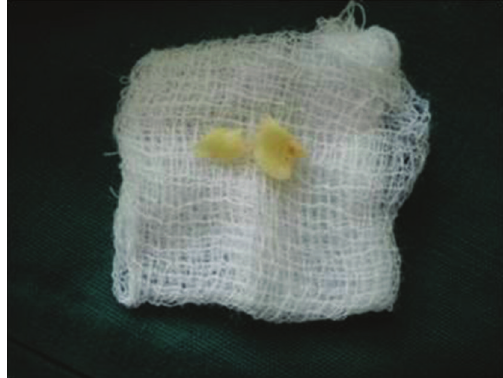
Figure 11: Buccal view of dental fragments of fractured 36, after surface disinfection with 0.12% chlorhexidine and application of dentin bonding